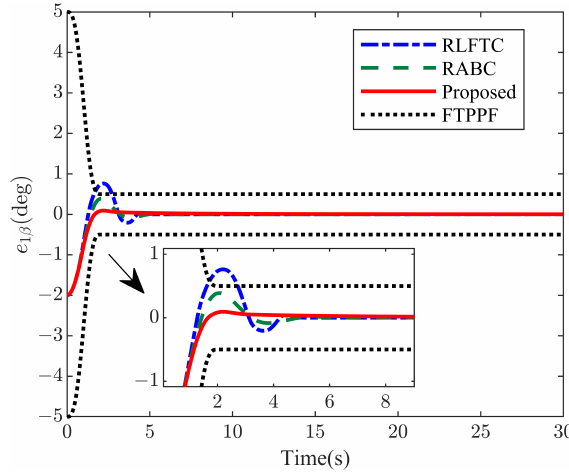
Figure 4. Time histories of the attitude tracking error e 1 β .